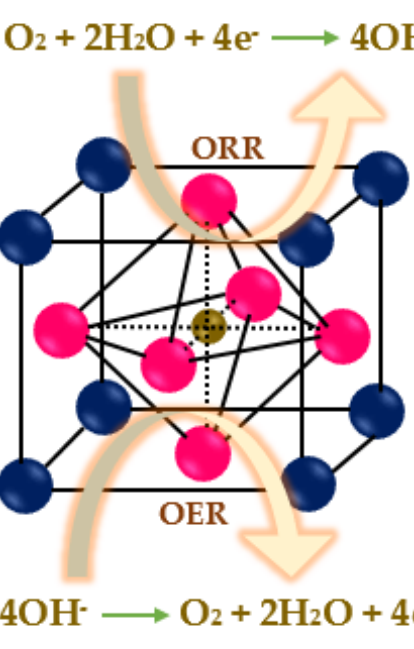
Scheme 1. Mechanism of oxygen reduction reaction (ORR) and oxygen evolution reaction (OER) in alkaline medium.